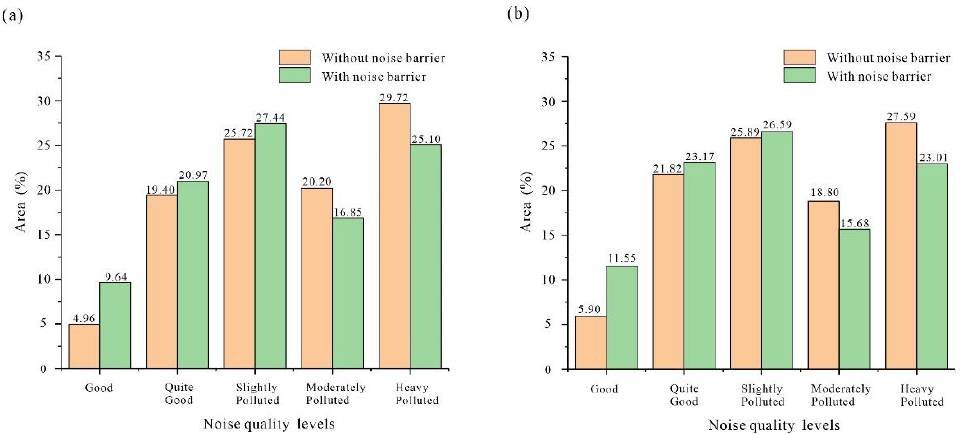
Figure 9. Comparison of the areas covered by different noise quality levels between the cases with and without noise barriers: ( a ) daytime; ( b ) nighttime.